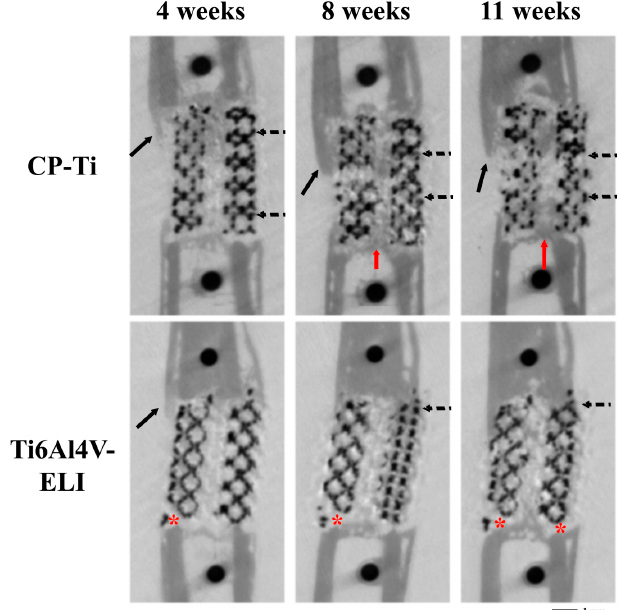
Figure 4. Representative longitudinal micro-CT scans of the femur illustrating the bone regeneration process. In vivo scans of defects grafted with two different titanium implants (CP-Ti or Ti6Al4V-ELI) after four, eight, and eleven weeks. In CP-Ti, there was more bone formation inside the canal of the titanium implants (red arrows), around (solid arrows), and inside (dotted arrows) the titanium implants compared to Ti6Al4V-ELI. Bone formation is mostly growing from the proximal ends. Distally from the Ti6Al4V-ELI implants, bone resorption is visualized (asterisk).